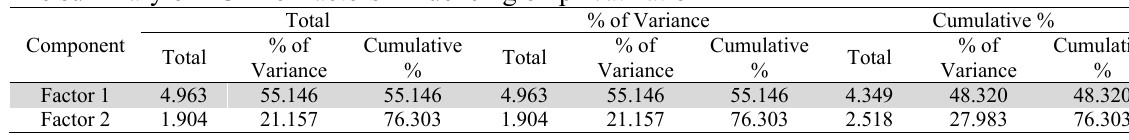
The summary of PCA for factors influencing on privatization Component